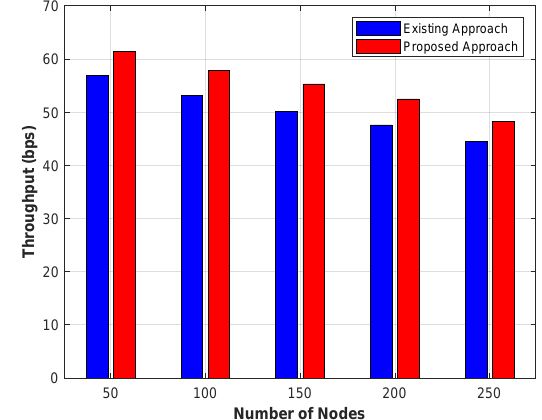
Figure 10. Network throughput.